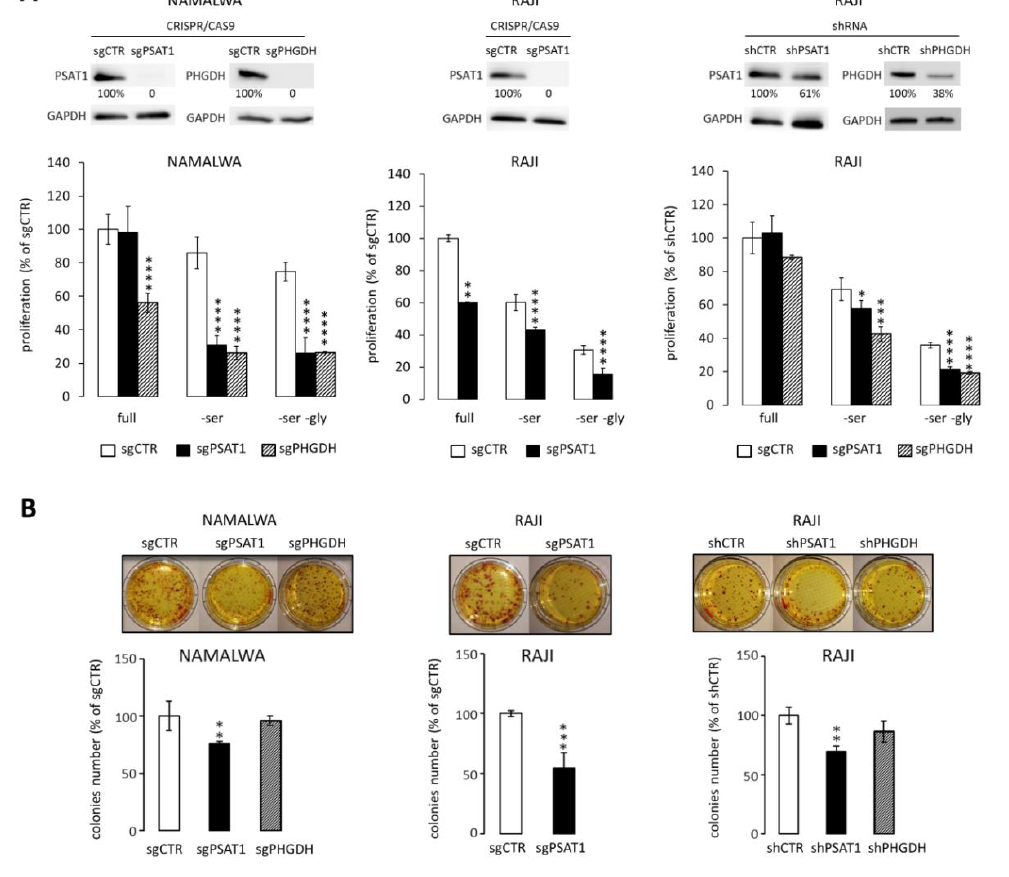
Figure 3. Disruption of PHGDH and PSAT1 expression decreases BL cell proliferation and clonogenicity. ( A ) Upper: CRISPR / Cas9 or shRNA-mediated targeting of PHGDH and PSAT1 in NAMALWA and RAJI cells. The protein expression of PSAT1 / PHGDH was assessed relative to GAPDH using densitometry. Lower: proliferation of NAMALWA and RAJI cells with knocked-down expression of PHGDH or PSAT1. Cells were grown in either full, Ser- or Ser / Gly-depleted medium. Cell proliferation was assessed using MTS assay and presented relative to control cells (sgCTR or shCTR) grown in the full medium. ( B ) PHGDH and PSAT1 genetic inhibition decreases BL cells’ clonogenic potential. Bar graphs in ( A ) and ( B ) represent the averages from three independent experiments performed in triplicates ± SD. Statistical di ff erences were assessed using t -test; * for p < 0.05; ** for p < 0.01 and *** for p < 0.001.